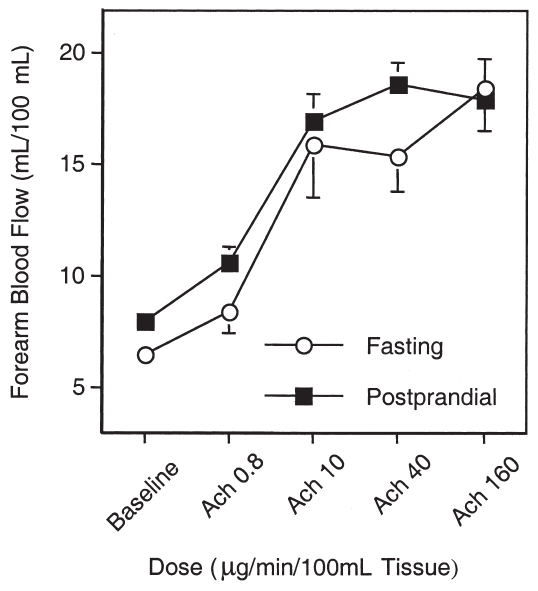
Figure 1 Dose-response curve of forearm blood flow during endothe- lium-mediated stimu- lation with acetyl- choline (Ach) while fasting and after intake of a fat